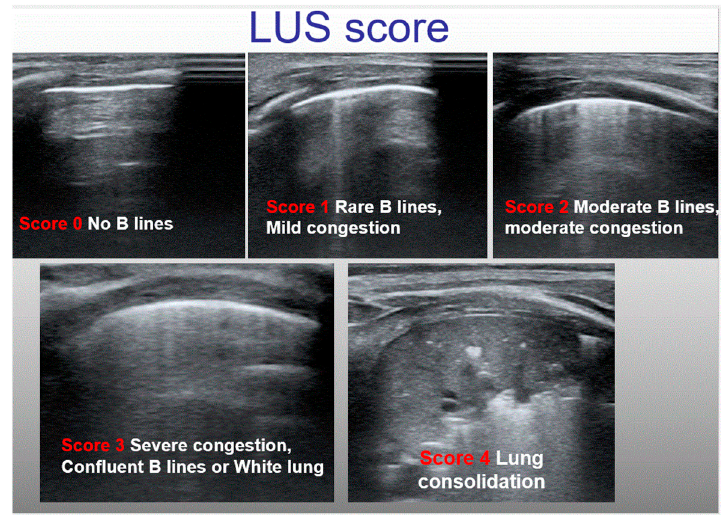
Figure 2. An example of semiquantitative LUS score that we have recently validated.